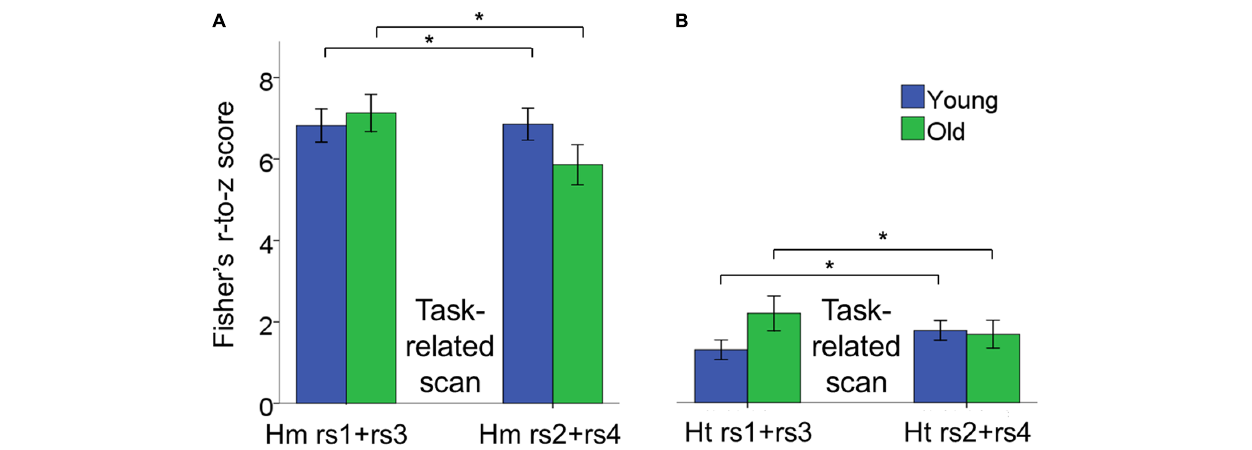
FIGURE 6 | Bar plots showing the age × scan location interaction effect for inter-hemispheric functional connectivity. (A) Changes in connectivity in homotopic pairs of regions. (B) Changes in connectivity in heterotopic pairs of regions. In both cases, functional connectivity increased after task performance in YA, whereas it decreased in OA and we observed this pattern of results within both the pre- and post-test sessions. Moreover, homotopic functional connectivity was greater than heterotopic functional connectivity. Error bars represent SEM. Hm rs1+rs3, homotopic rest scans before task-related scans; Hm rs2+rs4, homotopic rest scans after task-related scans; Ht rs1+rs3, heterotopic rest scans before task-related scans; Ht rs2+rs4, heterotopic rest scans after task-related scans.